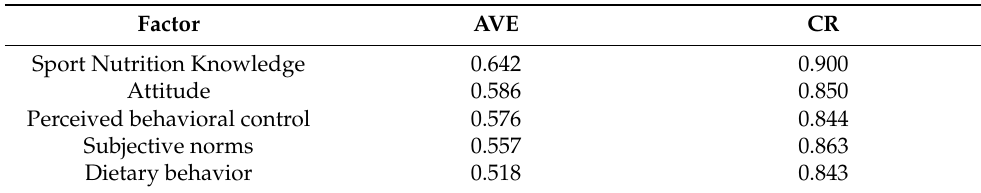
Table 3. Model AVE and CR